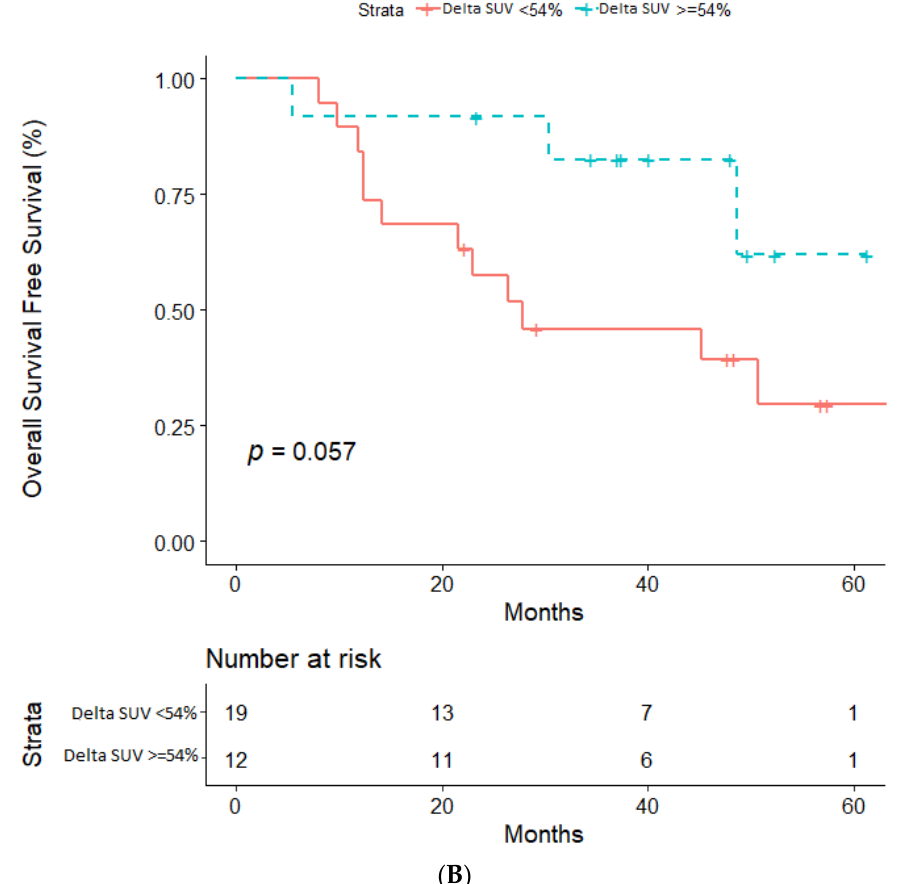
Figure 3. Kaplan–Meier survival estimates based on differences in metabolic response at three months. ( A ) Progression Free Survival in non-LRs ( B ) Overall survival in non-LSs.